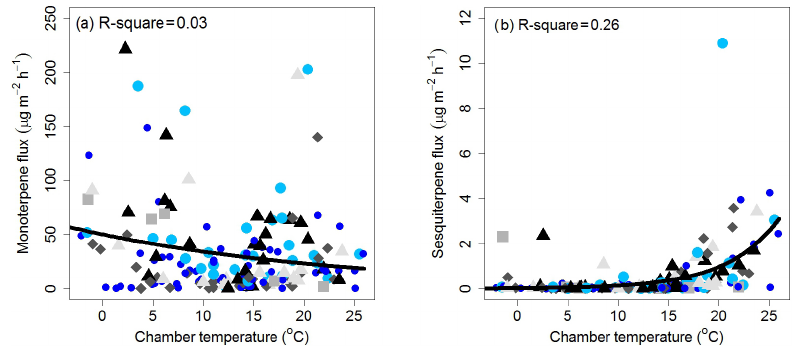
Figure 2. Relationship between monoterpene ( a , R 2 = 0 . 03, p value < 0.01) and sesquiterpene ( b , R 2 = 0 . 26, p value > 0.05) fluxes (µgm − 2 h − 1 ) and chamber temperature, presented as combined data from the different treatments (Control: soil was non-trenched, Tr50: the ingrowth of mycorrhizal fungi was allowed, and Tr1: decomposers were the only source) with vegetation ( + ) and those with bare soil ( − ). The treatments (Control += small blue circle, Control −= solid blue circle, Tr50 += filled gray triangle point-up, Tr50 −= filled gray square, Tr1 += filled gray diamond, and Tr1 −= filled black triangle point-up) were measured during periods 1–6,